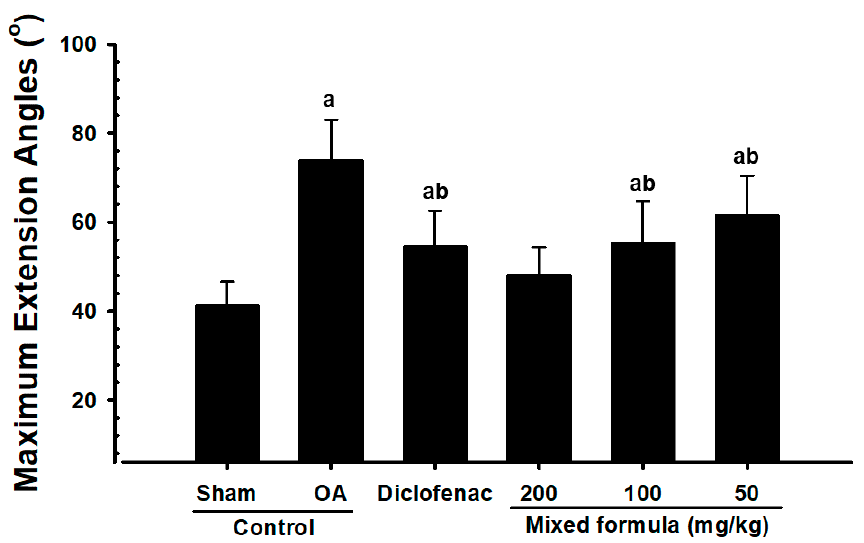
Figure 3. Maximum knee extension angles in sham-operated or OA rabbits. Values are expressed as mean ± S.D. of eight rabbits, in degrees ( ◦ ). AR = Aqueous extracts of Achyranthis Radix; OA = Osteoarthritis; EC = Aqueous extracts of Eucommiae Cortex; PCP = Dried Pomegranate Juice Concentrated Powder. a p < 0.01 as compared with sham control; b p < 0.01 as compared with OA